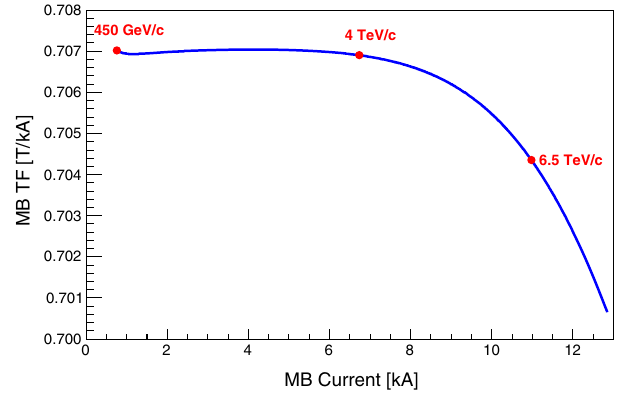
FIG. 4. Transfer function of the LHC main dipole magnets as a function of the circuit current.